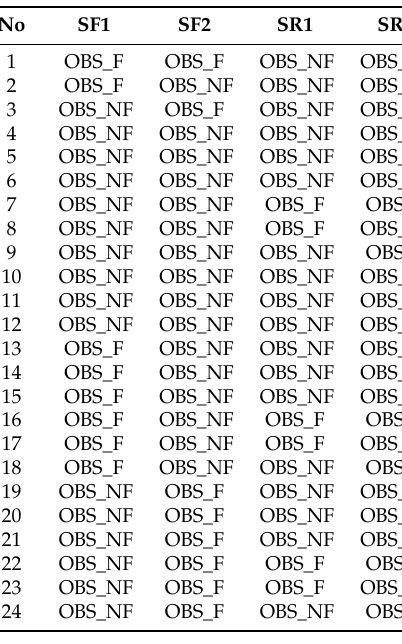
Table 1. Fuzzy logic